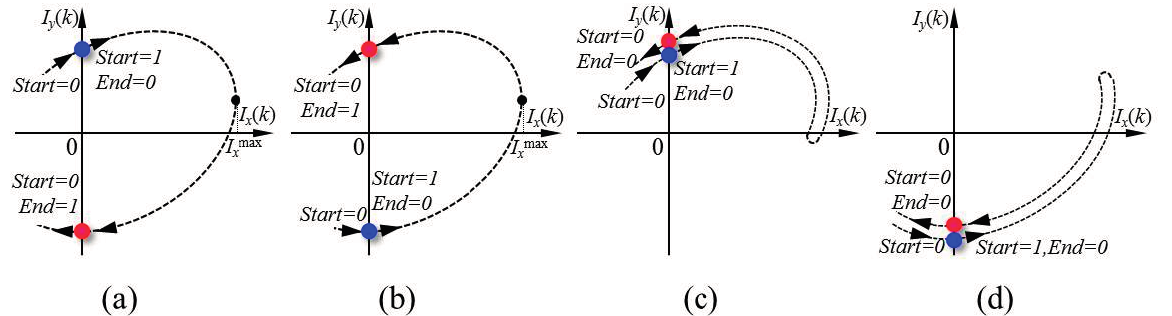
Figure 6. Detection of peak value for I xmax . ( a , b ) I xmax was detected successfully; ( c , d ) I xmax was not